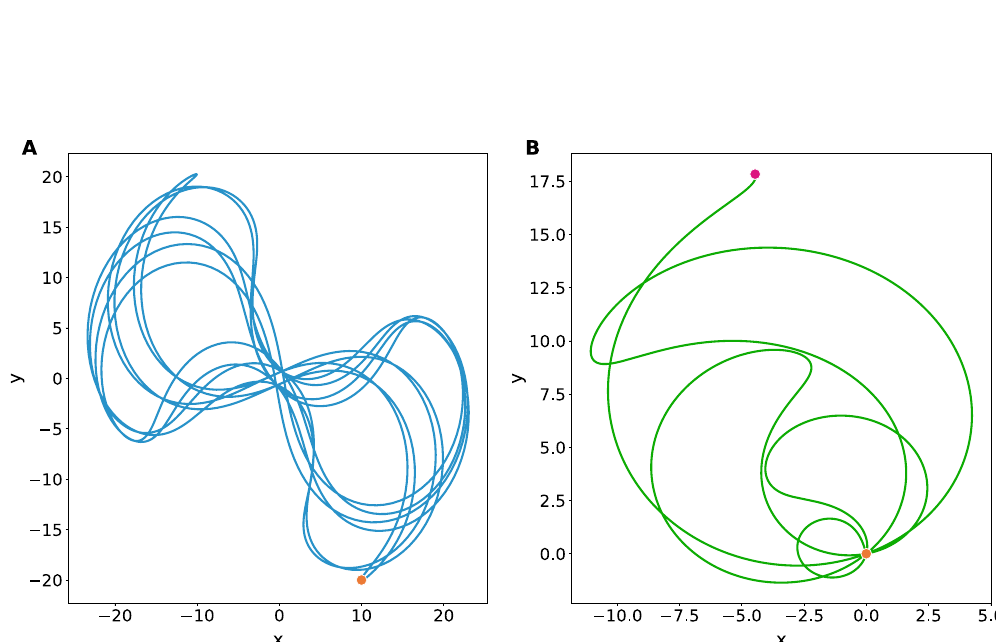
Figure 2. (A) Semiclassical closed trajectory in the plane xOy generated from the initial conditions 20 ) and ( p , p 5, 20 ) . The corresponding dimensionless amplitudes of the elastic field ( x , y ) ( 10, x y ) = ( − = − π 10 which lie in the region of stability as for Fig. 1. The loop closes after a period T β 2 are β 1 4 and = = − The orange dot represents its initial and final positions. (B) Broken loop of inverted free evolution. It takes the 5, 20 ) with the amplitudes β 1 ( 0, 0 ) and ( p x , p y ) ( initial conditions ( x , y ) = = − lie exactly in the separatrix between the stability and instability regions. For any operation that is realised with 2 to complete the control operation. The orange (red) dot amplitudes of this kind, it will take a period of T = represents its initial (final)